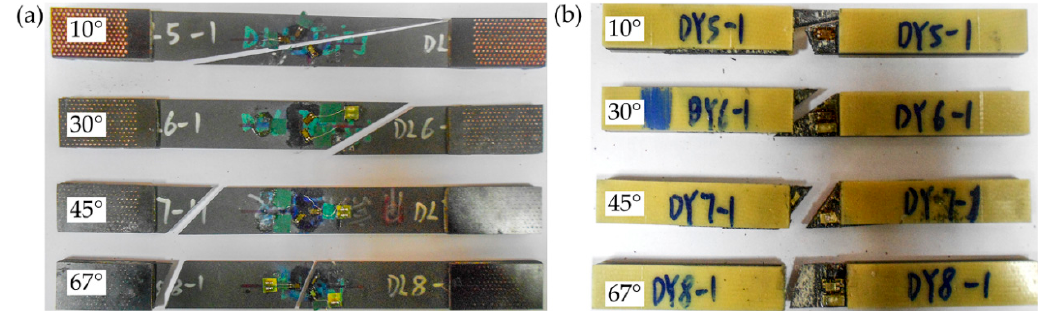
Figure 4. Failure modes in the experiments: ( a ) Off-axis tension; ( b ) Off-axis compression.